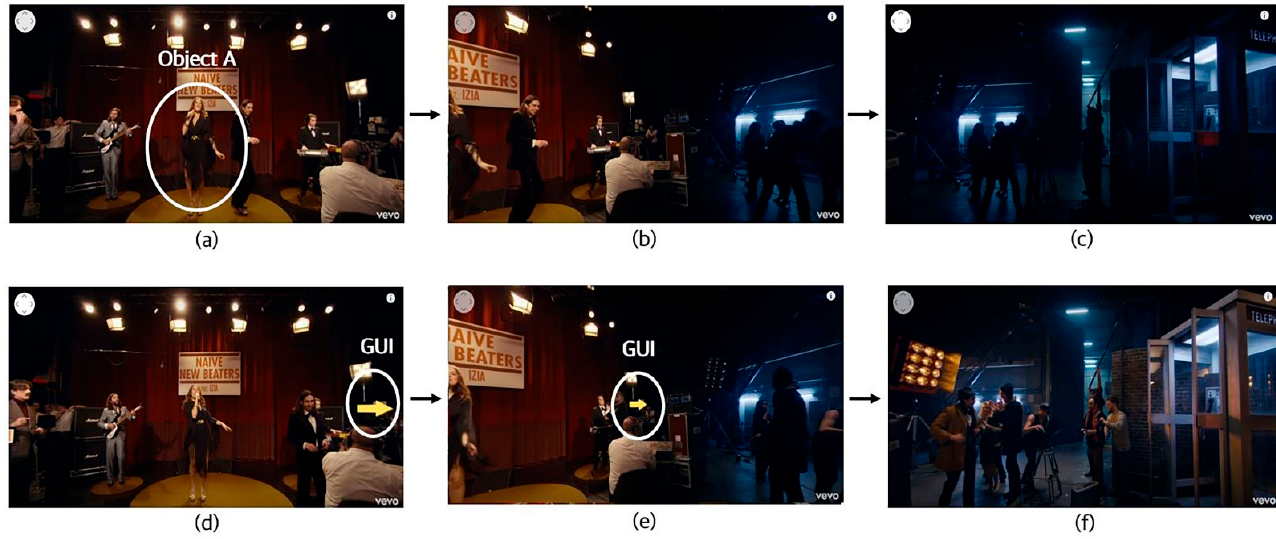
Figure 5. Directed Case using ‘GUI insert’ (video No. 8). ( a ) The user’s attention fixates on object A, ( b ) The scene where GUI is not inserted, ( c ) The space is dark except for the space where object A plays, ( d ) The scene where GUI is inserted, ( e ) The user’s attention moves to the right along the GUI, ( f ) The user can see the scene where the lighting is brightened and a new object appears.